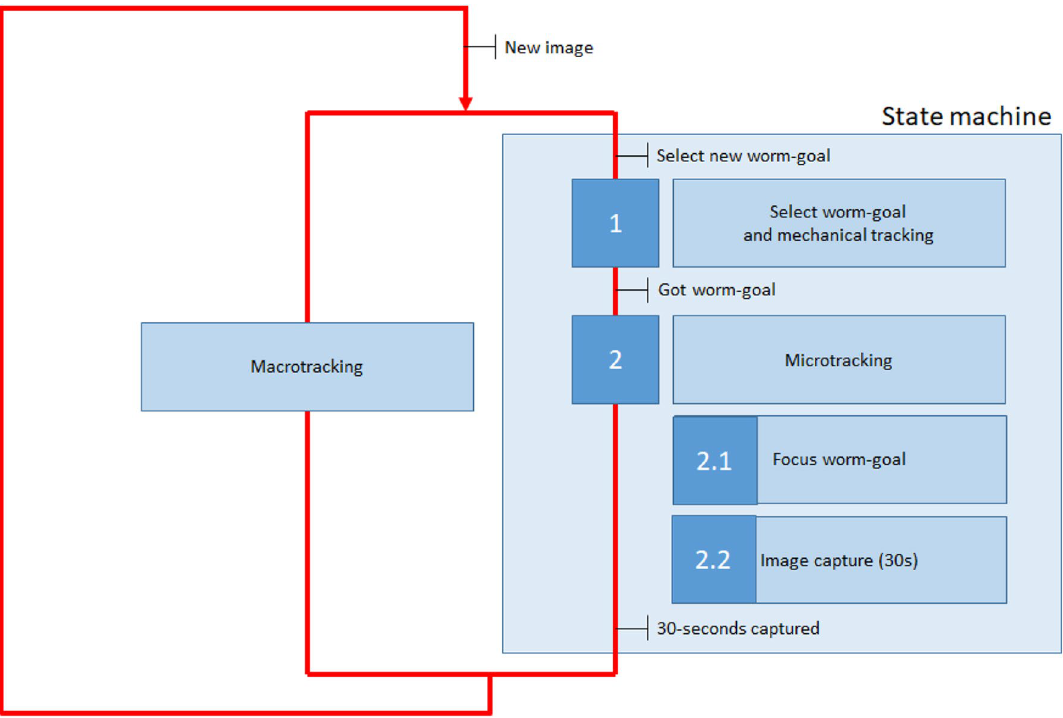
Figure 5. State machine. This flowchart shows the tasks of the state machine. Macrotracking is running constantly (it is software tracking), while state machine executes (1) when the worm has been selected.